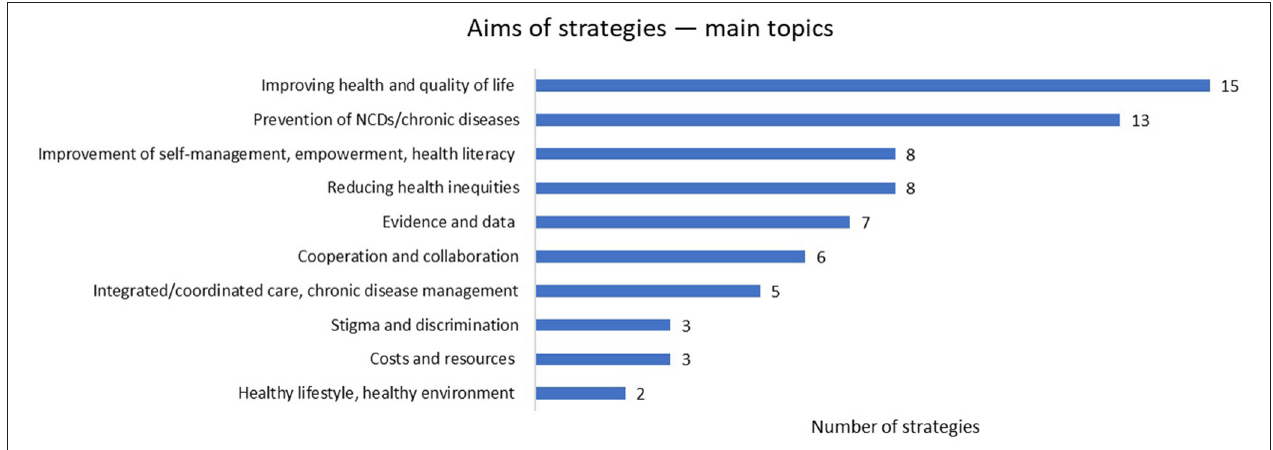
FIGURE 1 | This figure presents the aims of strategies and their main